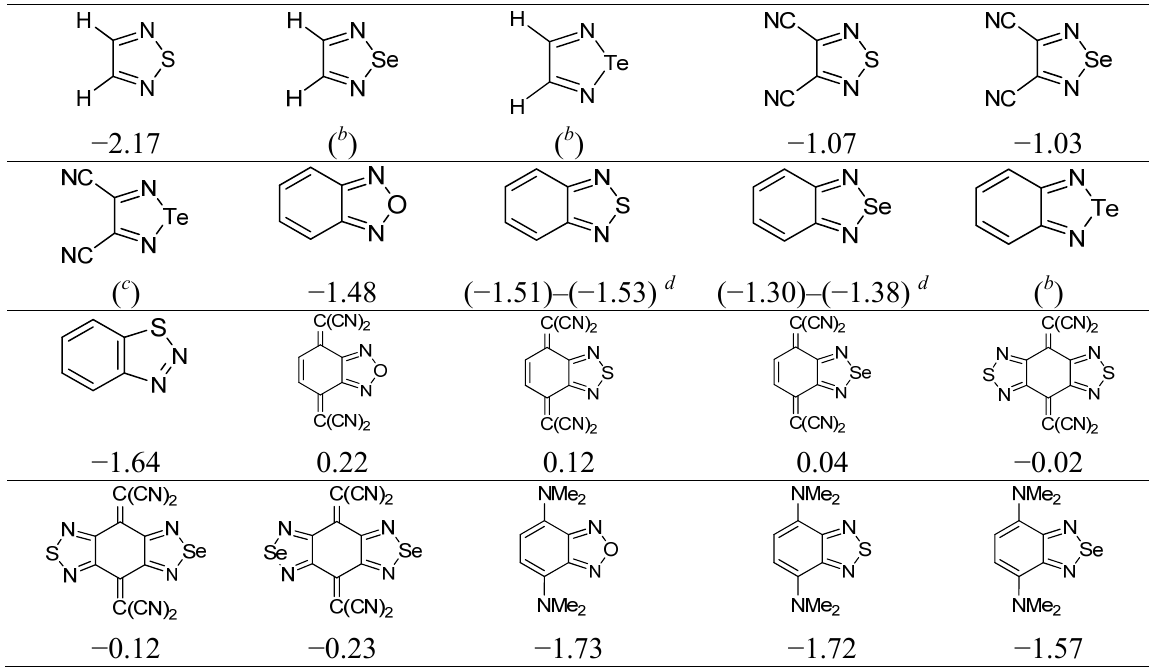
Table 7. Electrochemical potential -1/0 (V) (E π -heterocycles.